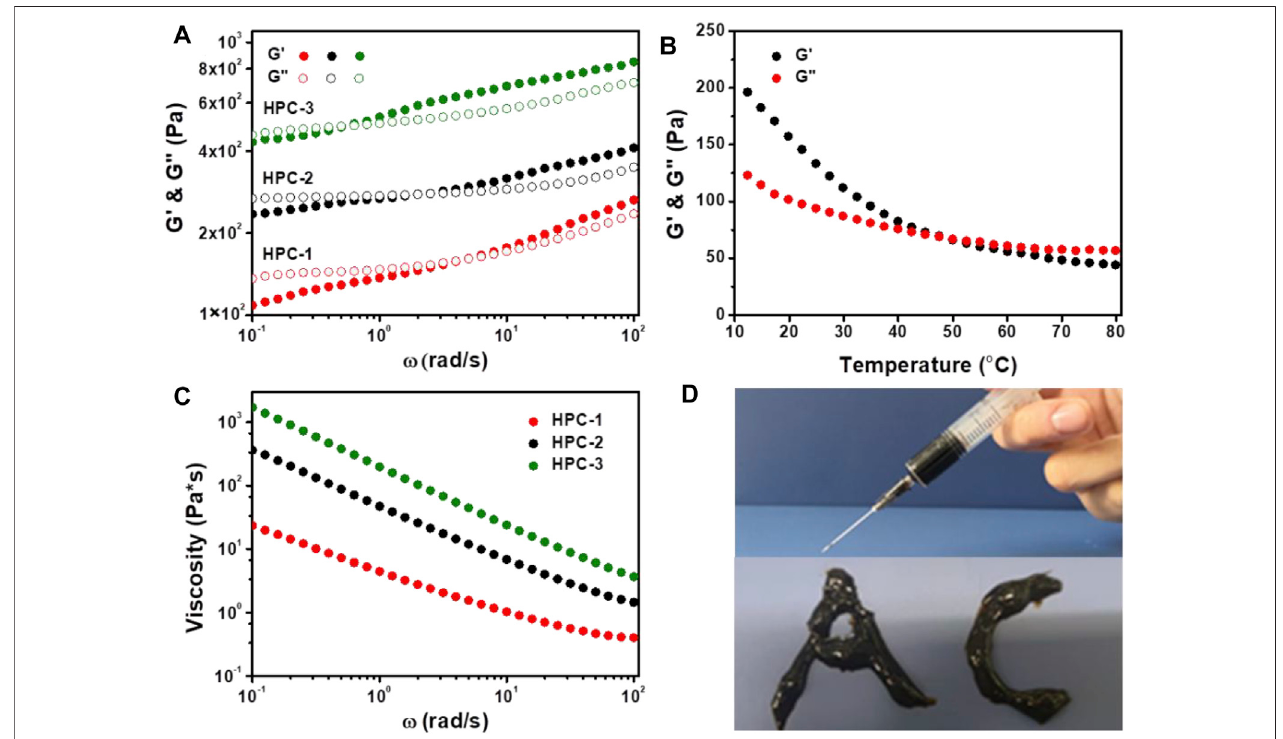
FIGURE 2 | (A) G ′ and G ″ as a function of ω for the HPC hydrogels. (B) Temperature dependence of G ′ and G ″ for the HPC-2 hydrogel (C) The shear viscosity of HPC hydrogels as a function of ω . (D) HPC-2 hydrogel used as ink to write words.